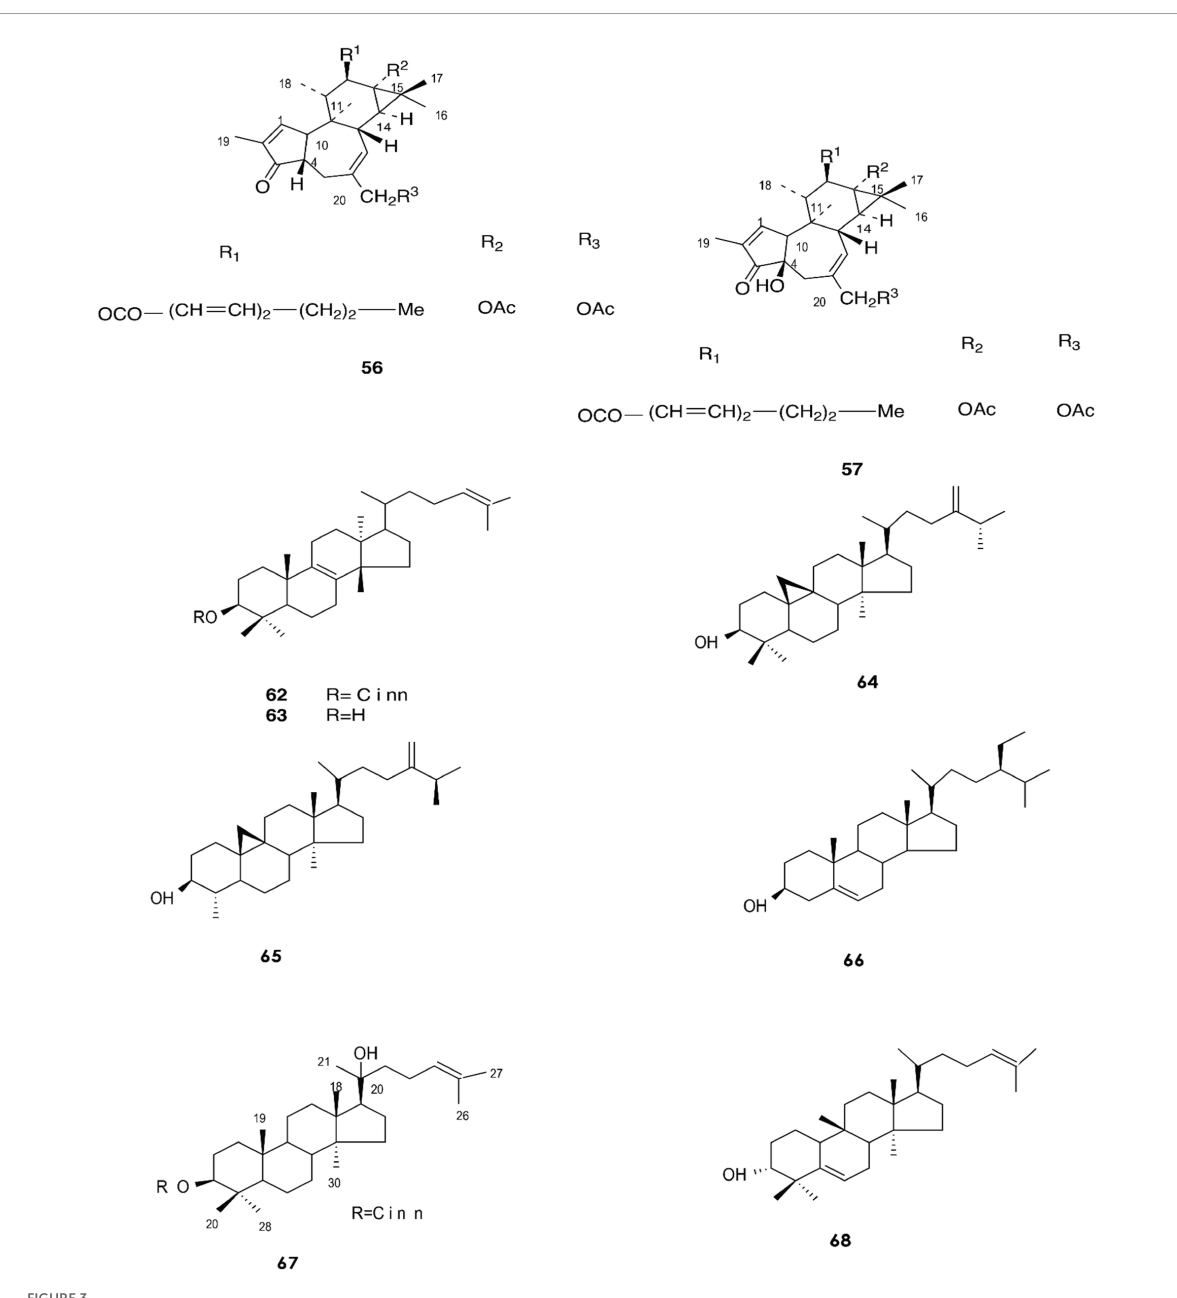
(27) using Fourier transform-ion cyclotron resonance mass spectrometry (FT-ICR MS) and Atmospheric Pressure Chemical Ionization APCI ( + ) FT-ICR MS. In addition, two diterpene esters (28, 29) were isolated by electrospray ionization Fourier transform ion cyclotron mass spectrometry ESI (-) FT-ICR MS and ESI (-) FT-ICR MS/MS (de Souza et al., 2019). The fresh latex collected from the roots of E. fischeriana has been analyzed using spectroscopic methods, HPLC, and